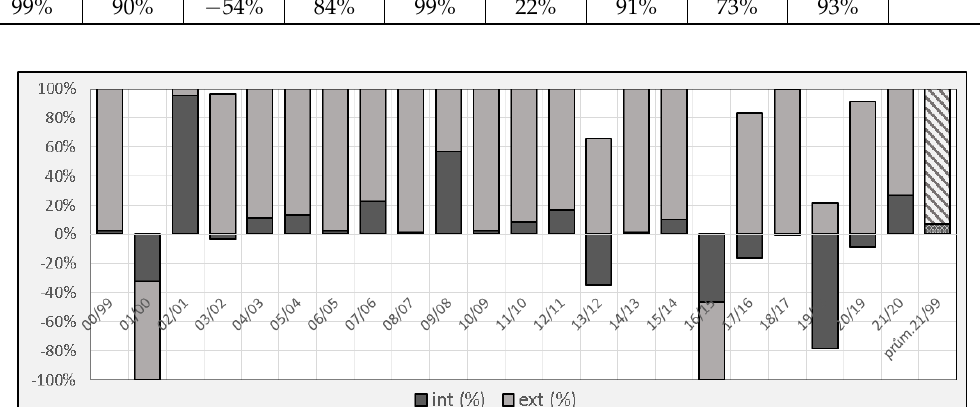
Figure 10. Apple ’s intensity and extensity development 1999 – 2021. Figure 10. Apple’s intensity and extensity development